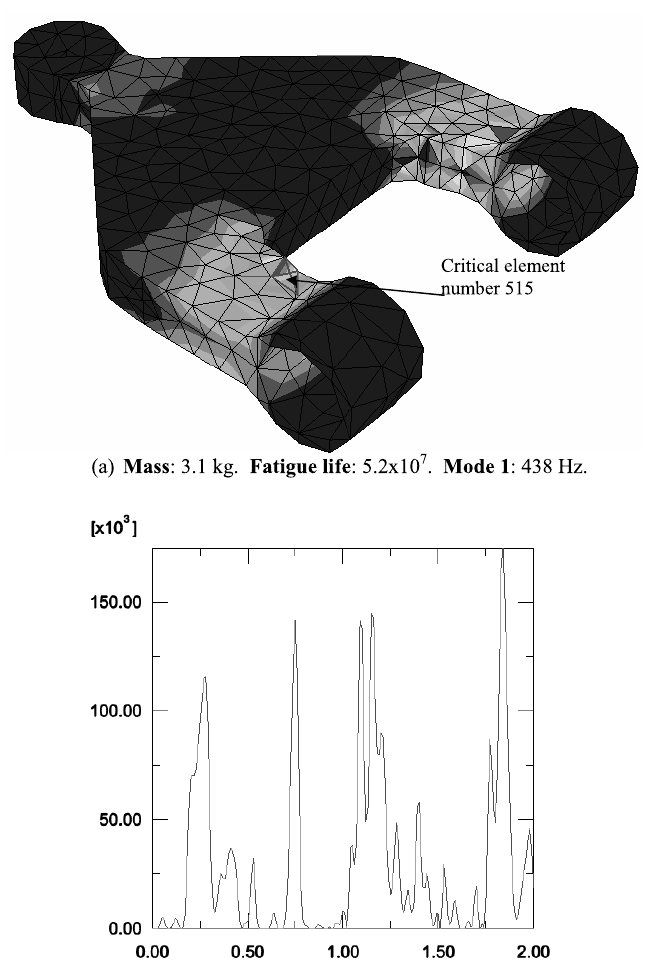
Fig. 10. Third optimization